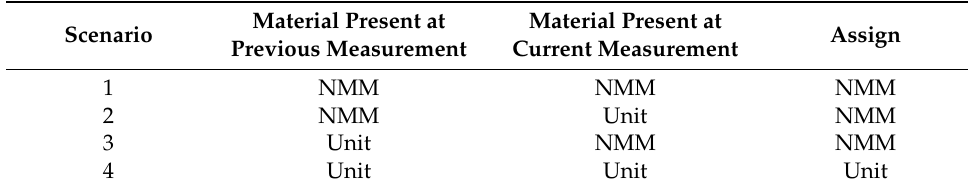
Table 1. The four erosional scenarios used to assign specific material to an individual streambank pin recession measurement, Walnut Creek,